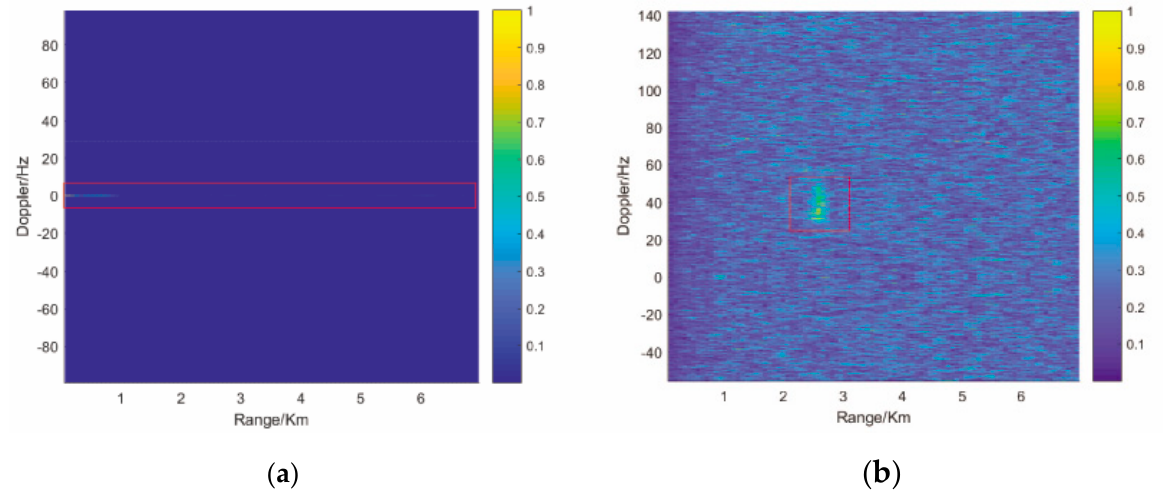
Figure 12. Coherent processing results based on FT. ( a ) Detection result without clutter cancellation. ( b ) Detection result with clutter cancellation.